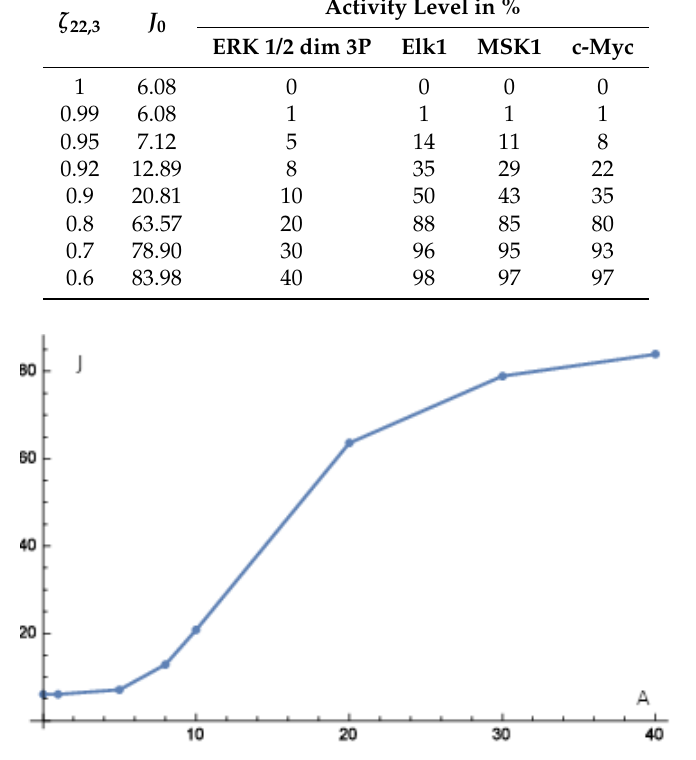
Figure 13. On the abscissa the activity level (A) of ERK1/2 dim 3P and on the ordinate the value ( J ) of J 0 is plotted. We see an abrupt increasing of the value of J 0 which can be interpreted as an abrupt deterioration of the corresponding treatment. Data points are from Table